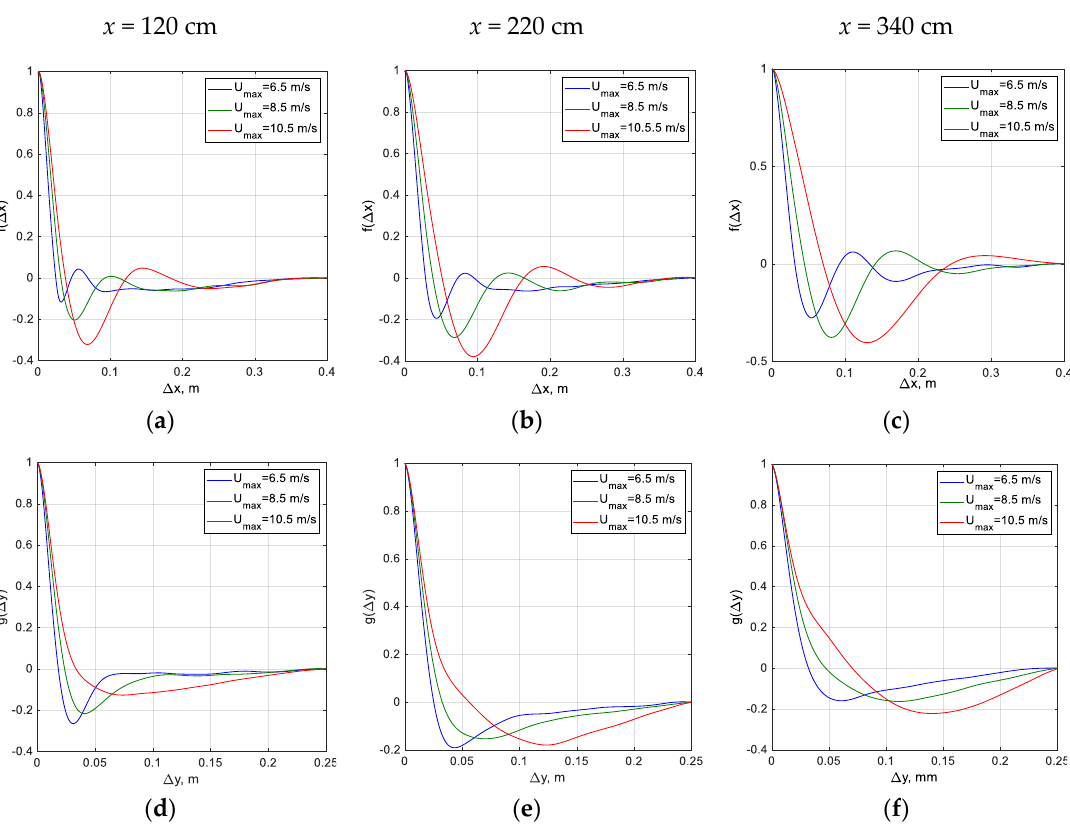
Figure 14. The spatial autocorrelation functions in the along wind ( a – c ) and crosswind ( d – f ) directions for three fetches x and three wind velocities U max = 8.5 m/s.